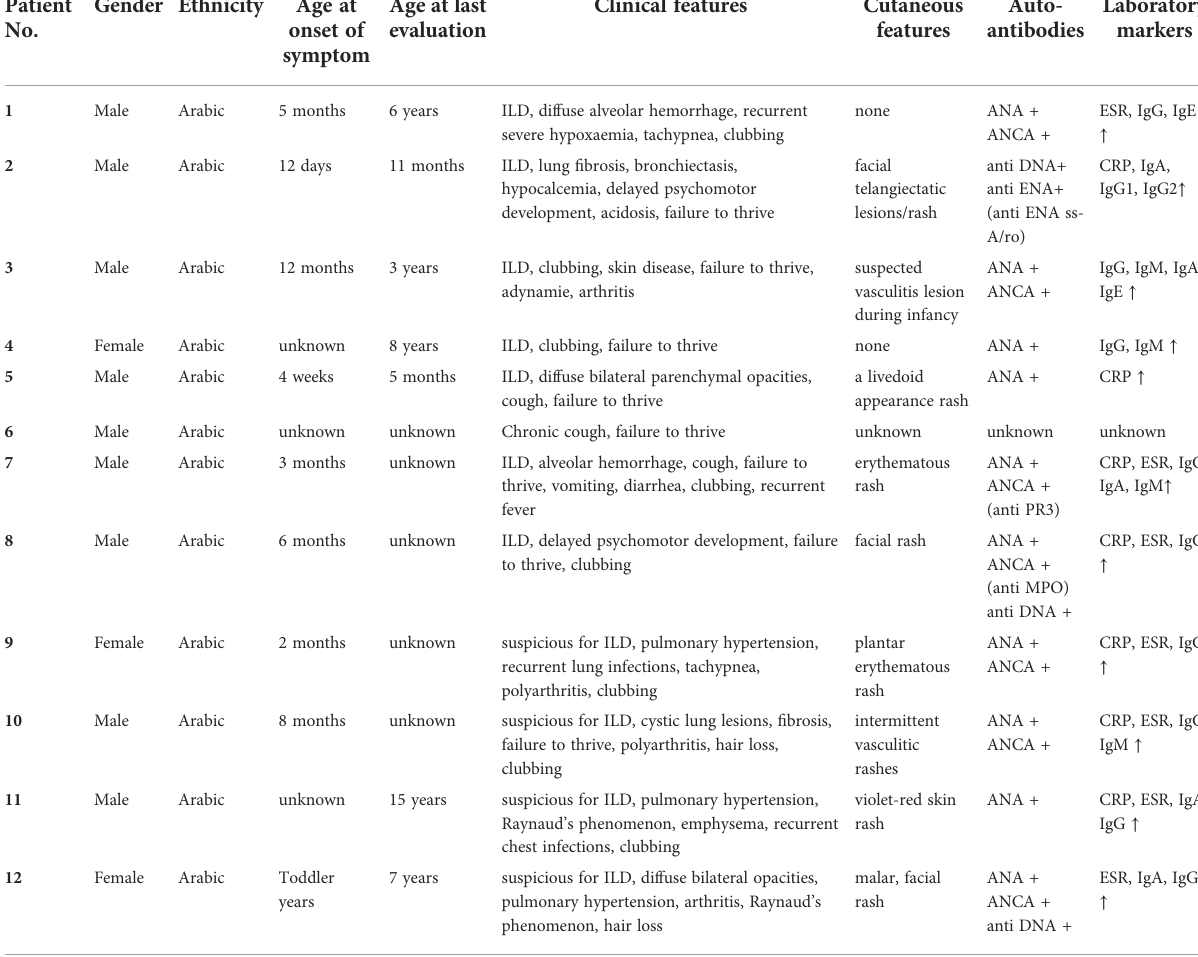
ILD, interstitial lung disease; ANA, antinuclear antibody; ANCA, antineutrophil cytoplasmic antibody; anti ENA ss-A/ro: anti extractable nuclear antibodies; anti-PR3, anti-proteinase 3 antibody; anti-MPO, anti-myeloperoxidase; c-ANCA, cytoplasmic antineutrophil cytoplasmic antibody; dsDNA, double-stranded DNA; CRP, C-reactive protein; ESR, erythrocyte sedimentation rate; Ig, Immunoglobulin; +,